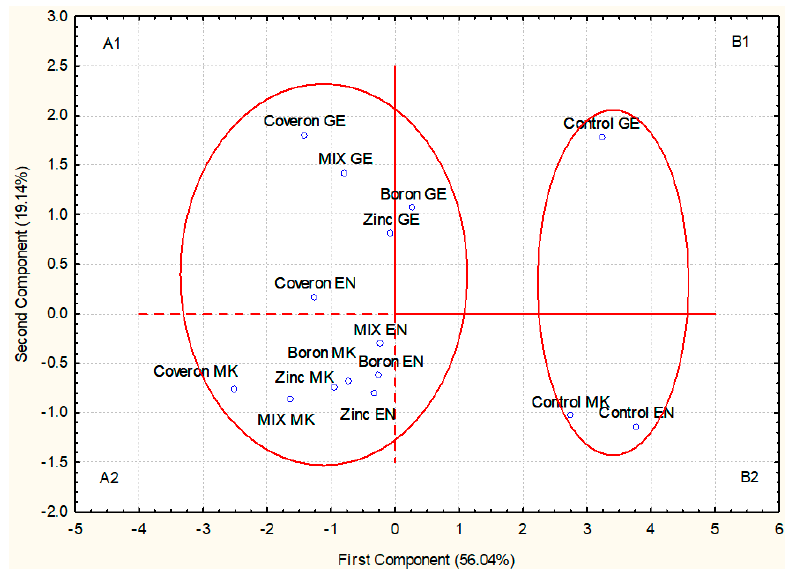
Figure 1. Principal component analysis (PCA) for the treatment effect on seed germination and shoot and root length of lettuce ( Lactuca sativa, GE—Genius, MK—Majska kraljica, EN—Endivia.